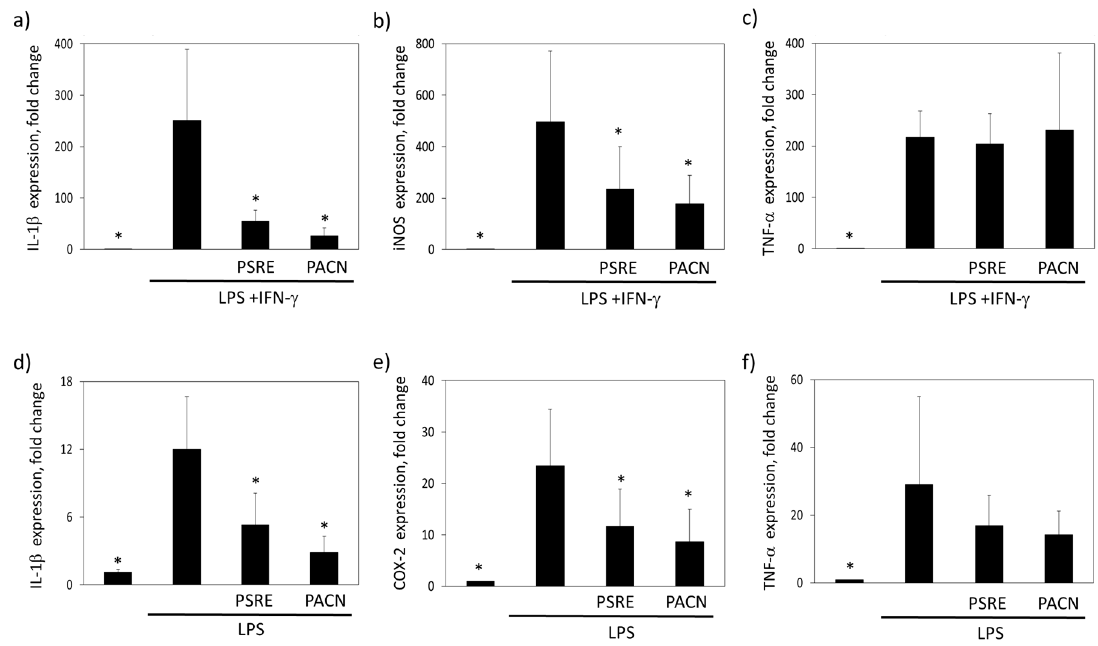
Figure 6. The e ff ect of Pelargonium sidoides root extract (PSRE) and proanthocyanidins from PSRE (PACN) on proinflammatory gene expression in bone marrow-derived macrophages ( a – c ) and peripheral blood mononuclear cells ( d – f ) after LPS or LPS and IFN- stimulation. ( a , d ) IL-1 β ( a , b ) iNOS, ( c , f ) TNF- and ( e ) COX-2. The data are expressed as a fold change of glucose-6-phosphate isomerase gene transcription and presented as mean ± SD of three independent measurements. *—significantly di ff erent from the LPS-treated samples (ANOVA followed by a Tukey’s multiple comparison test, p < 0.05).